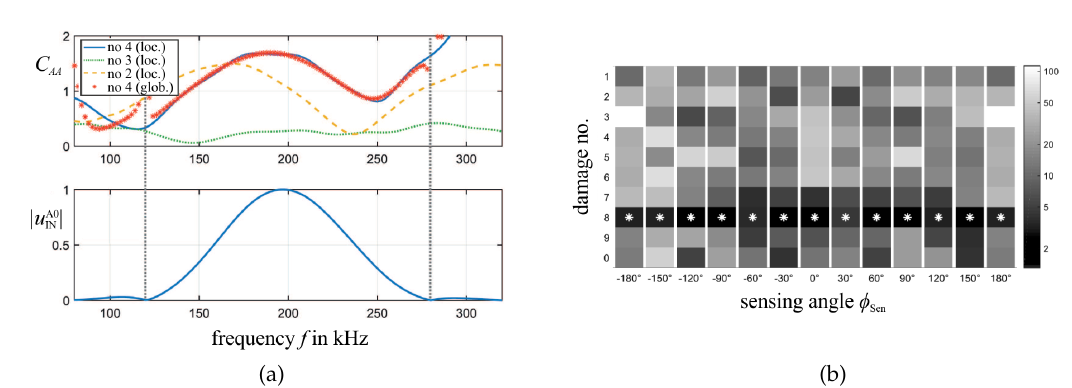
Figure 9. ( a ) (top) Comparison of the global results (asterisks) to the amplitude coefficients C AA taken from the WDIC catalog for different kind of damages in one sensing direction φ Sen = 210 ◦ . (bottom) Normalized amplitude of the incident wave displacement damage No. 8 (global transient model) to damages Nos. 1–10 (local steady-state models) (asterisks indicate smallest deviation, and thus the identified result) [71].